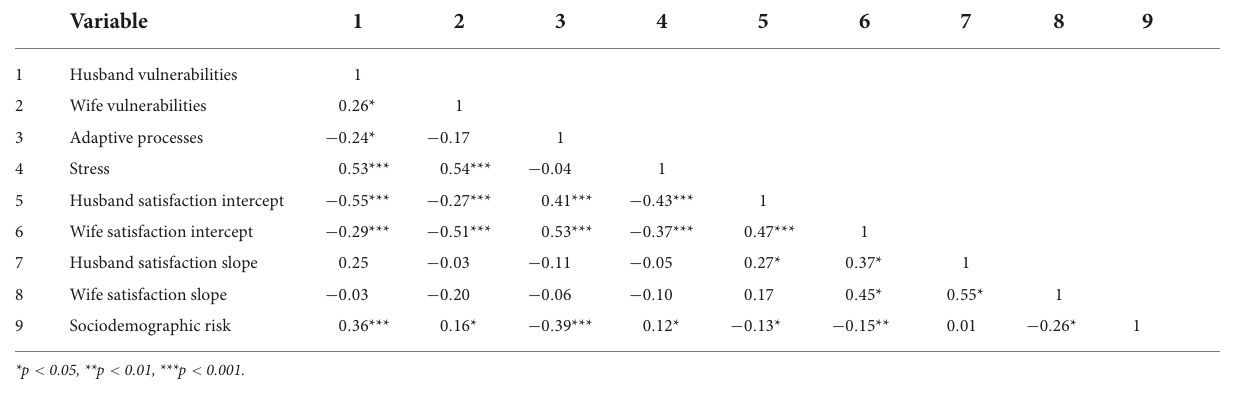
TABLE 2 Correlation matrix for latent variables and observed variables in final model.